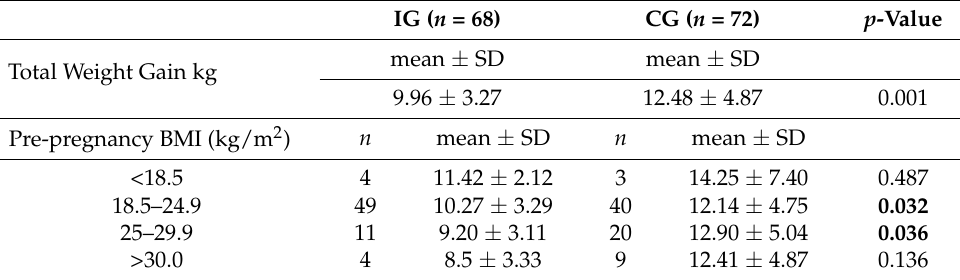
Table 3. Total weight gain at delivery in kg by BMI subgroups.